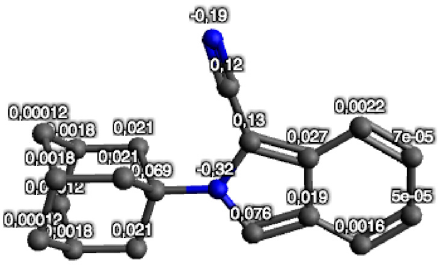
Figure 5. The atomic net charges e of the DFT-optimized structure of 1 . Hydrogens are not shown.